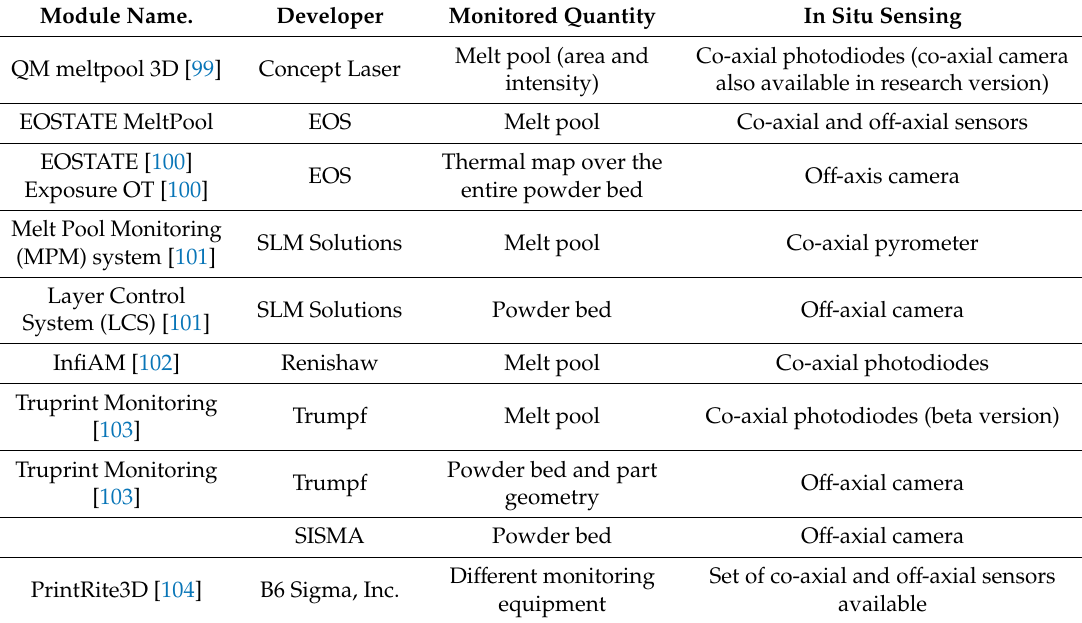
Table 2. List of commercial in situ sensing